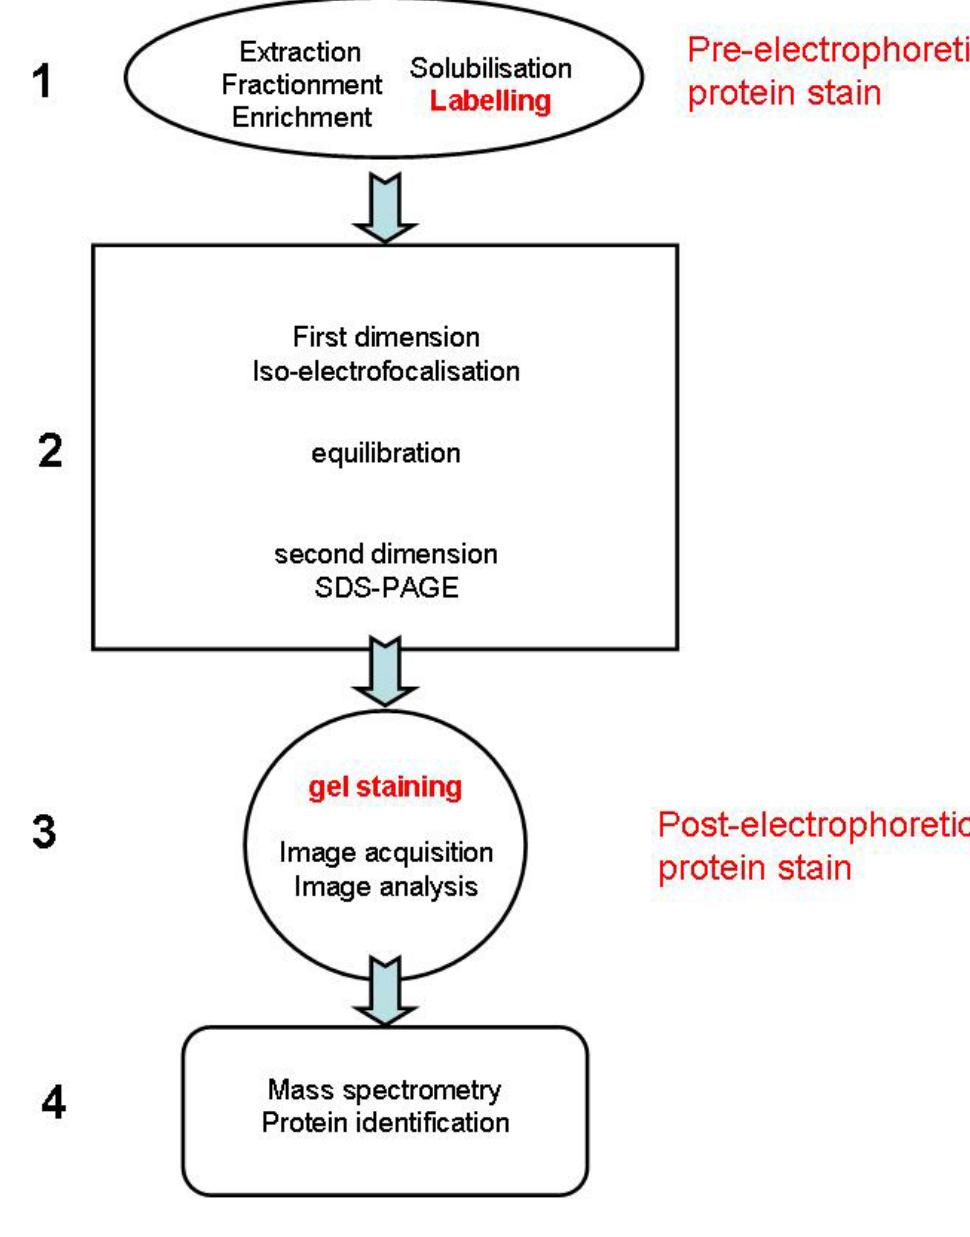
Figure 1. Pre-electrophoretic and post-electrophoretic protein staining during the different steps of